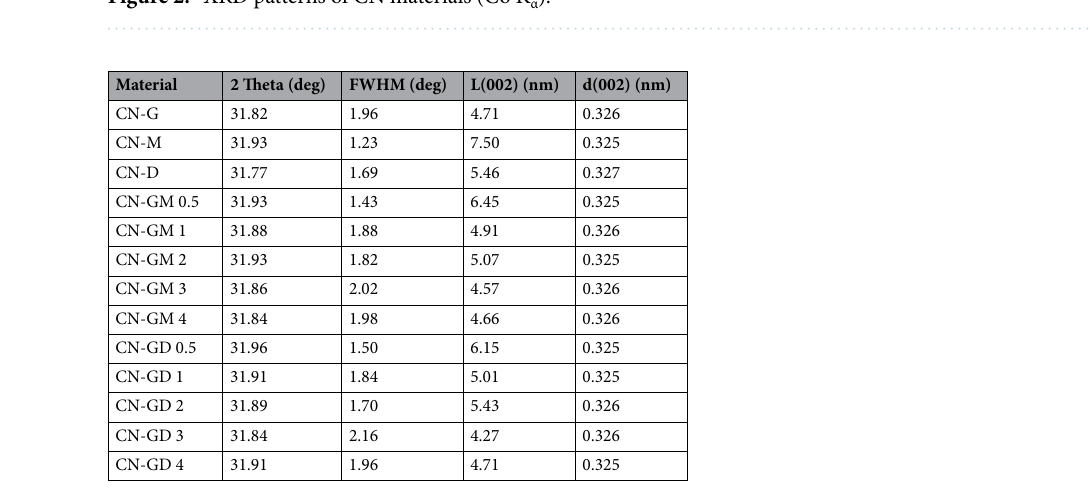
Figure 2. XRD patterns of CN materials (Co K α ).